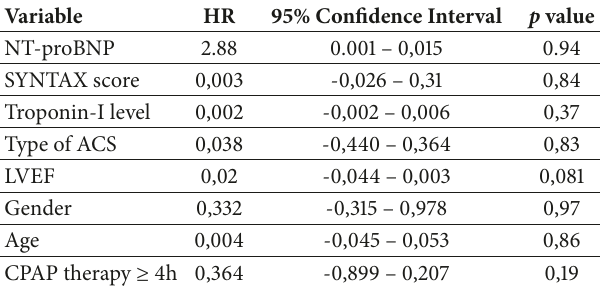
Table 3: Multivariate analysis of factors associated with AC ≥ 37% versus AC <